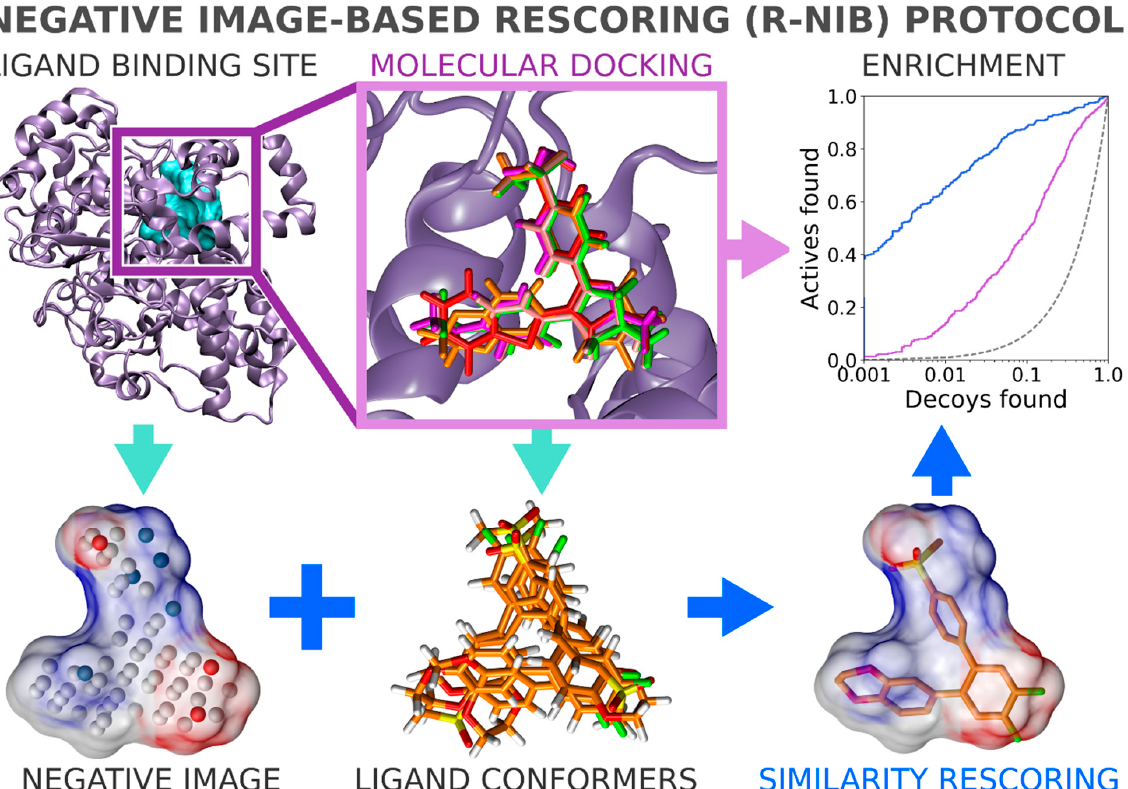
Figure 2. Negative image-based rescoring. The negative image-based rescoring (R-NiB) [16] begins with the flexible docking of ligands (green / red / magenta / orange stick models) into the binding site (magenta box) of cyclooxygenase-2 (COX-2; magenta cartoon; PDB: 3LN1 [2]; A chain) using a flexible molecular docking algorithm (e.g., PLANTS [17]). Here, the centroid coordinates of the bound inhibitor celecoxib (cyan opaque surface) are used in the docking. Several alternative flexible docking poses (e.g., n = 10) are output for the rescoring phase. Next, a cavity-based NIB model is generated with PANTHER [3] using the same celecoxib-based cavity centroid that was used in the original docking. The shape / electrostatics of the NIB model are directly compared against the ligand 3D conformers without geometry optimization using ShaEP [4]. With the directory of useful decoys (DUD) set [18], the initial docking enrichment (magenta line), which is already well above the random limit (dotted line), is improved by the R-NiB treatment (blue line). See Figure 1 for